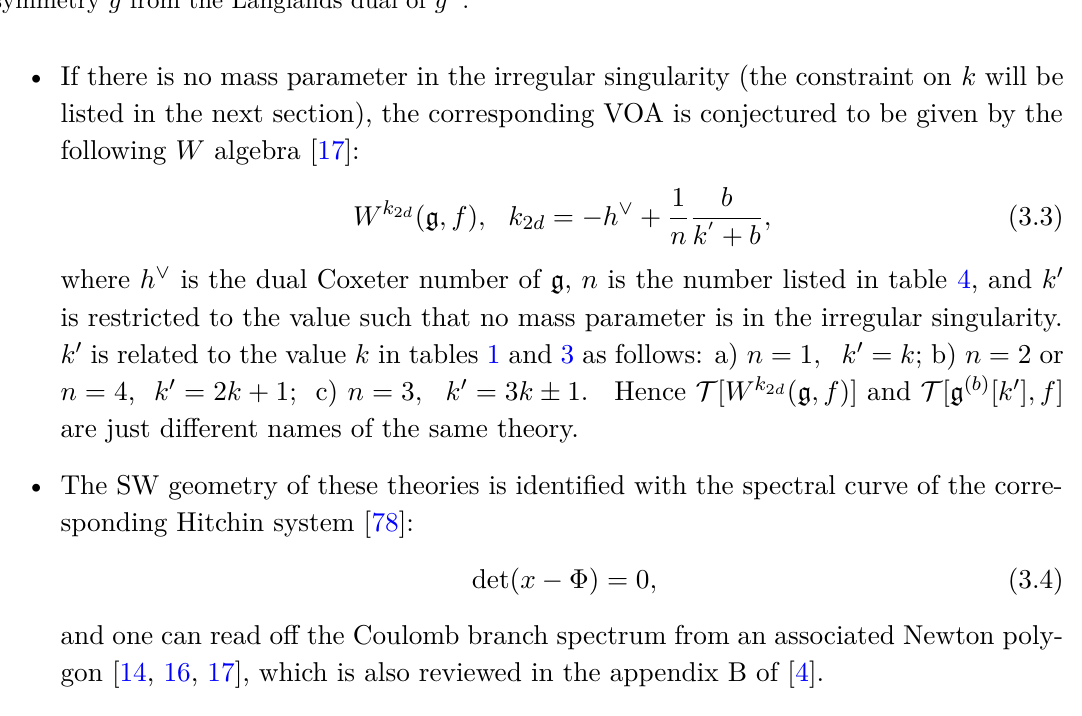
Table 2 . Outer-automorphisms of simple Lie algebras j , its invariant sub-algebra g ∨ and flavor symmetry g from the Langlands dual of g ∨